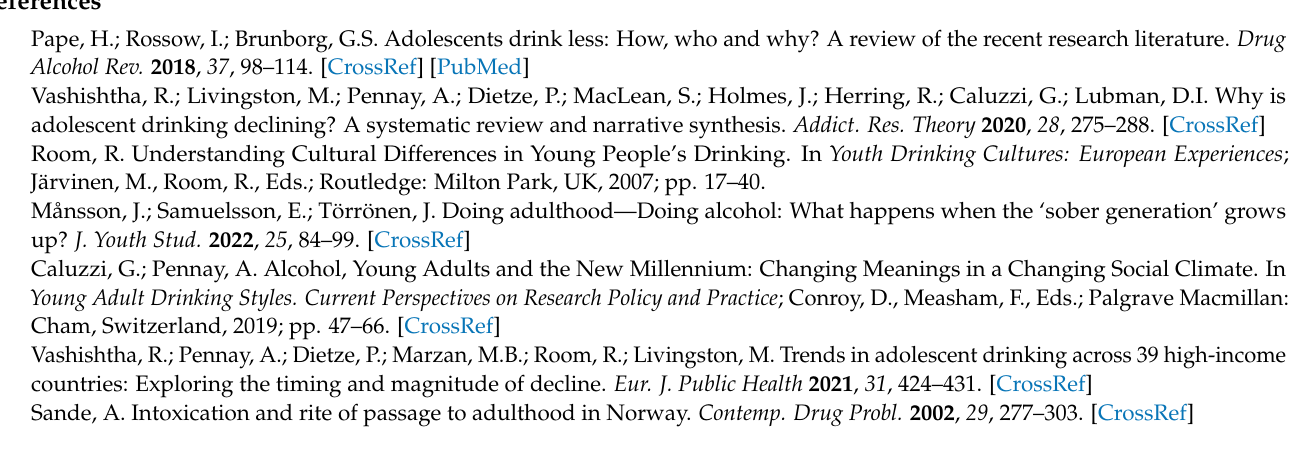
guide; S3: Figure of trajectories, assemblages, actancts and chains of